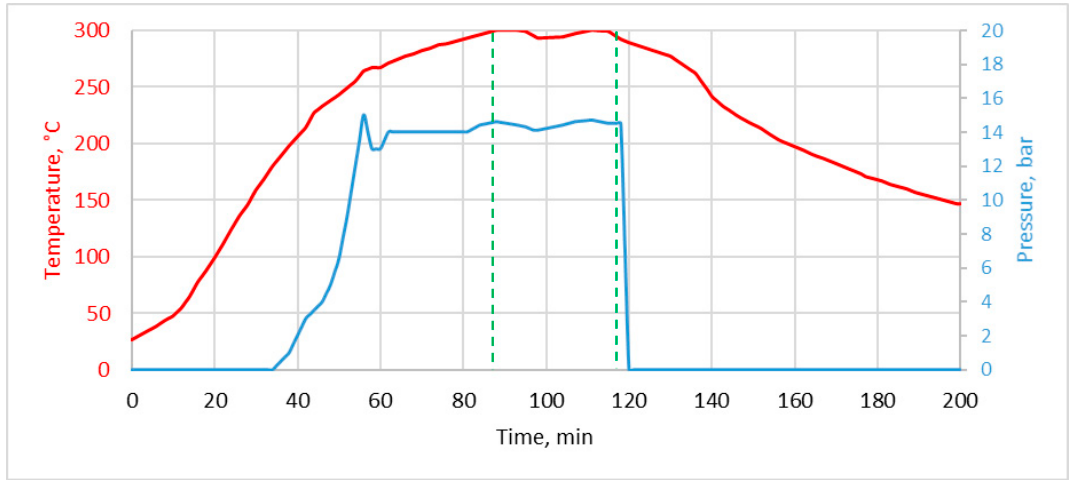
Figure 5. An example of temperature / pressure patterns during the high-pressure torrefaction with decreasing pressure (hpd) torrefaction, green dashed line stands for start and end of the torrefaction process (30 min).